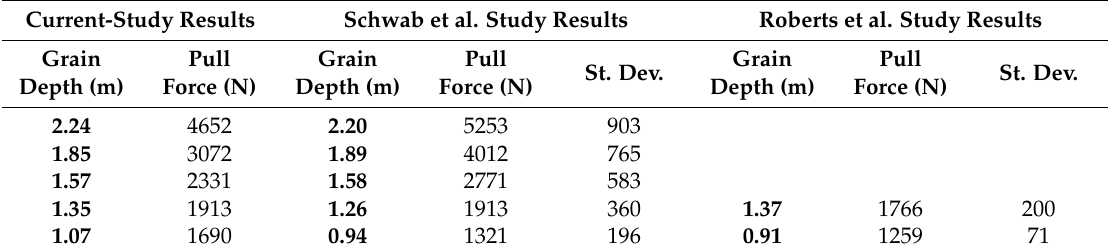
Table 3. Comparison between the current study and the Schwab et al. study results for vertical-force